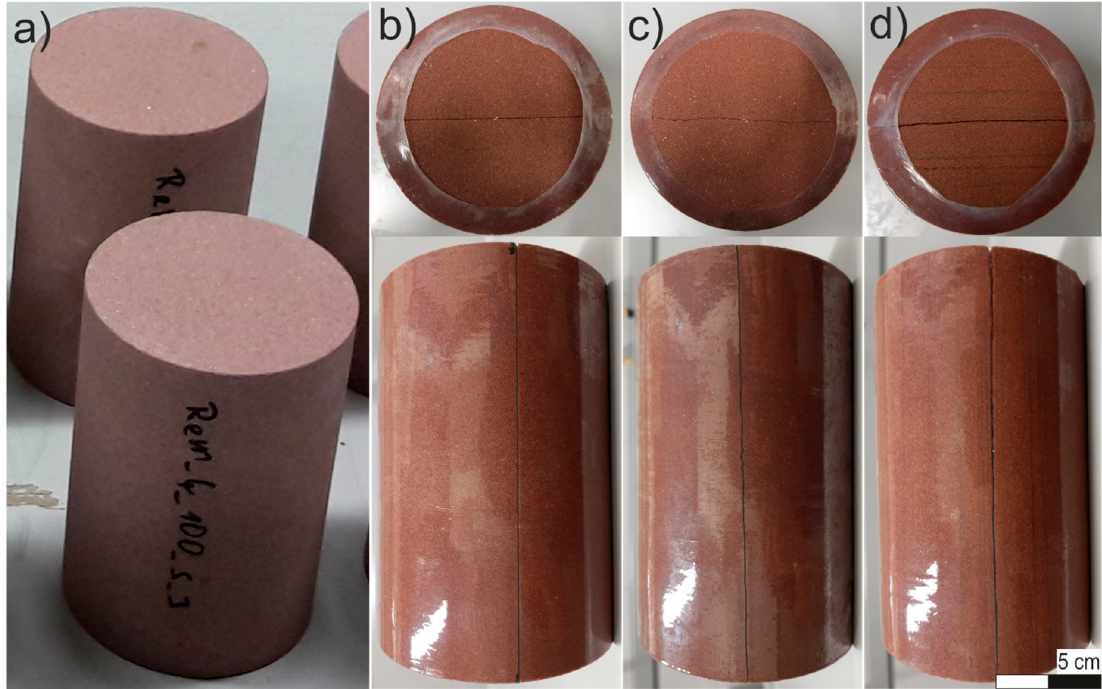
Figure 2. Used sandstone specimens for the experimental investigations. ( a ) raw specimens; ( b ) sawed specimen; ( c ) split specimen; and ( d ) natural fractured specimen.